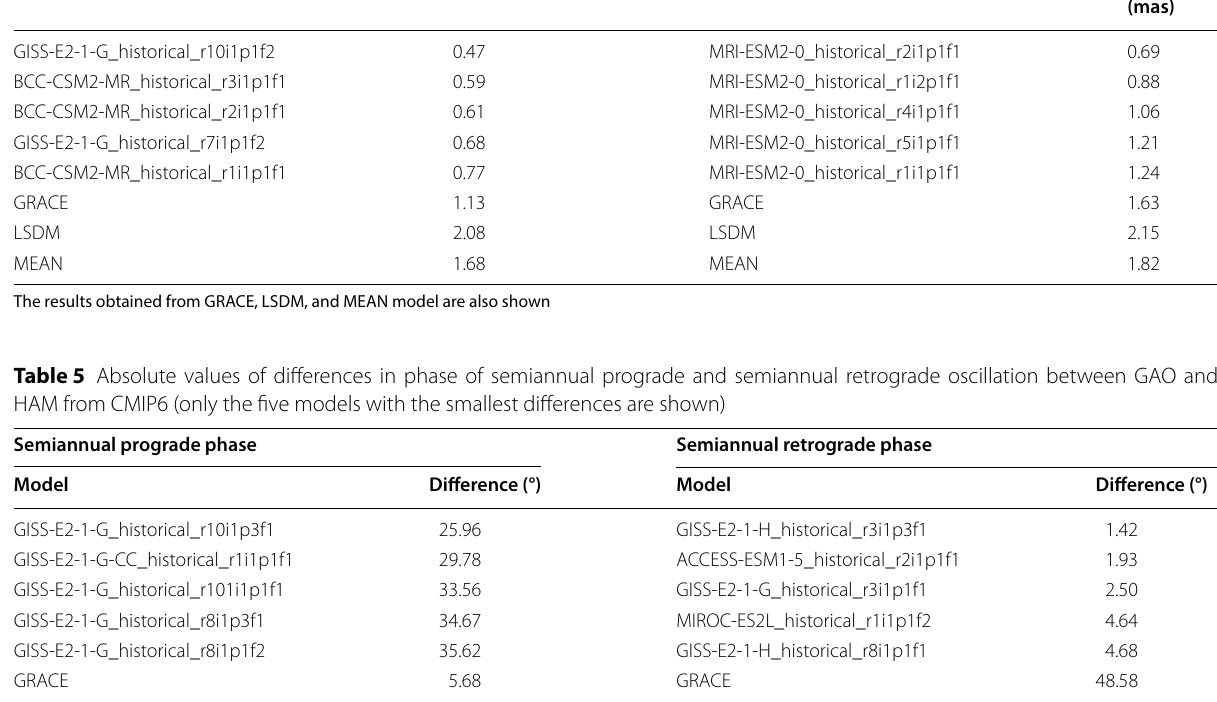
Table 4 Absolute values of differences in amplitude of semiannual prograde and semiannual retrograde oscillation between GAO and HAM from CMIP6 (only the five models with the smallest differences are shown)